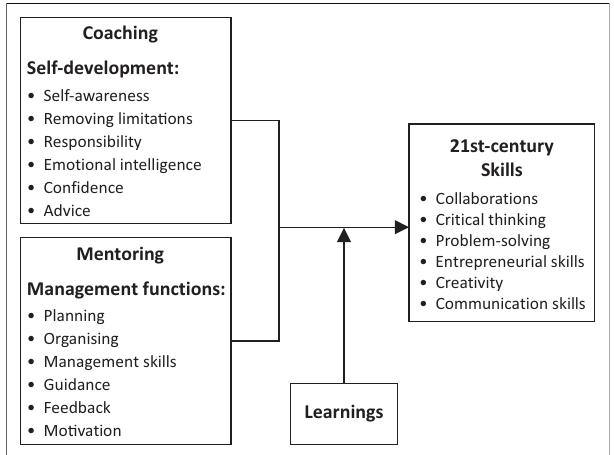
FIGURE 3: Linking